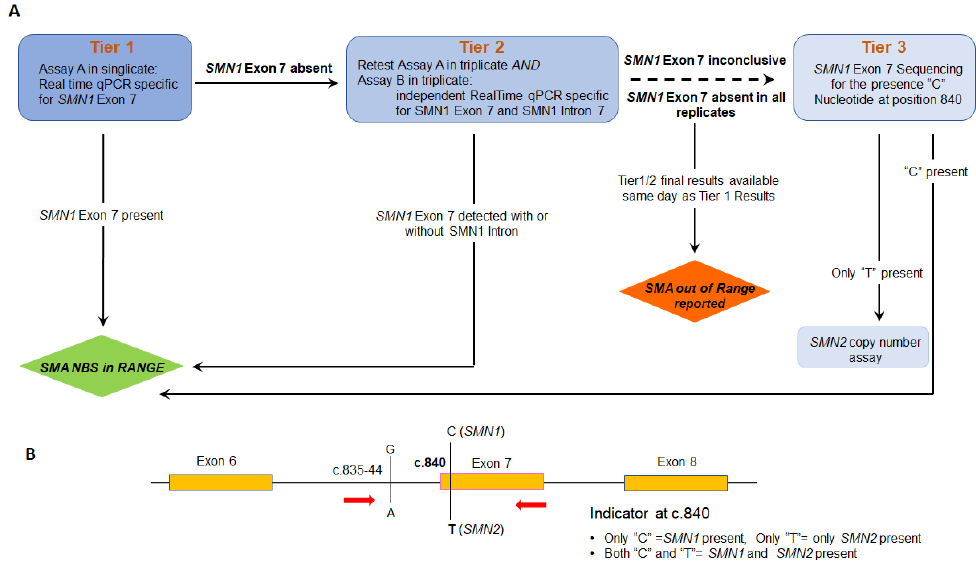
Figure 1. ( A ) Flow chart of current SMA screening algorithm at New England Newborn Screening program. ( B ) Primer locus targeting SMN1 gene during SMA sequencing. Primers were tagged with M13, and indicated in bold. SMA seq-F- 5 ′ - TGTAAAACGACGGCCAGT- AACCTTAACTGCAGCCTAATAATTG-3 ′ and SMA seq-R- 5 ′ - CAGGAAACAGCTATGACC- GCTGGCAGACTTACTCCTTAAT-3 ′ were used for sequencing.